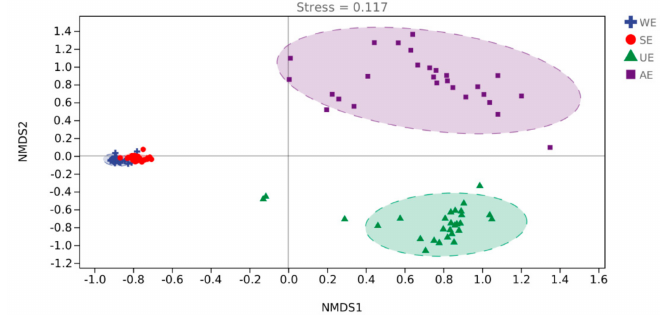
Figure 4. Two-dimensional sorting graph of nonmetric multidimensional scaling analysis (NMDS) analysis. Each point in the diagram represents a sample and di ff erent colors indicate di ff erent seasons (groups). It can be approximately assumed that the closer (farther) the distance between two points is, the smaller (larger) the di ff erence in microbial community between the two samples